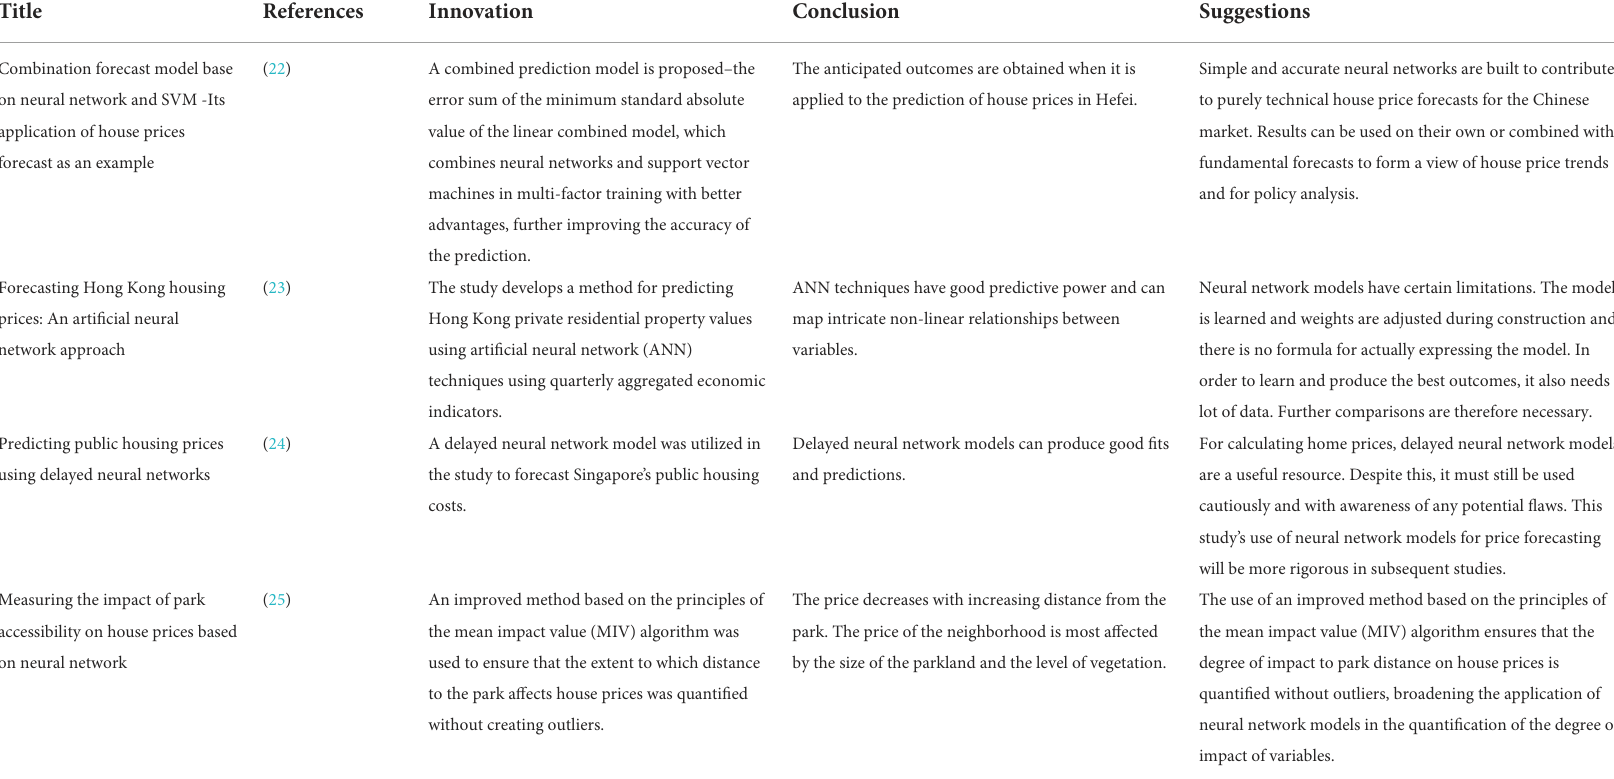
TABLE 3 Literature review of the neural network